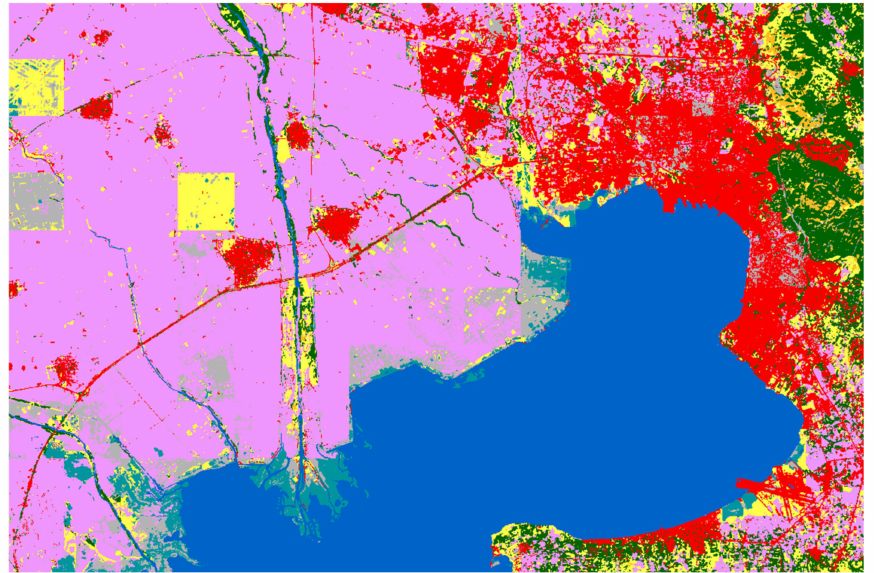
Figure 11. Land Cover Classification with modified SegFormer using the colour coding of Table